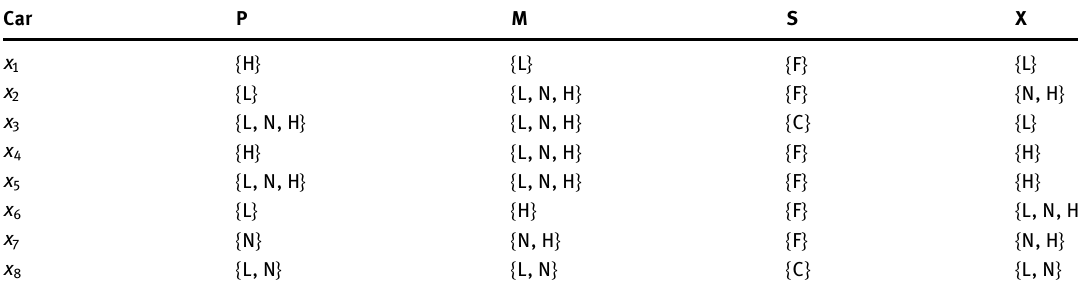
Table 2: A set - valued information system corresponding to Table 1 Car